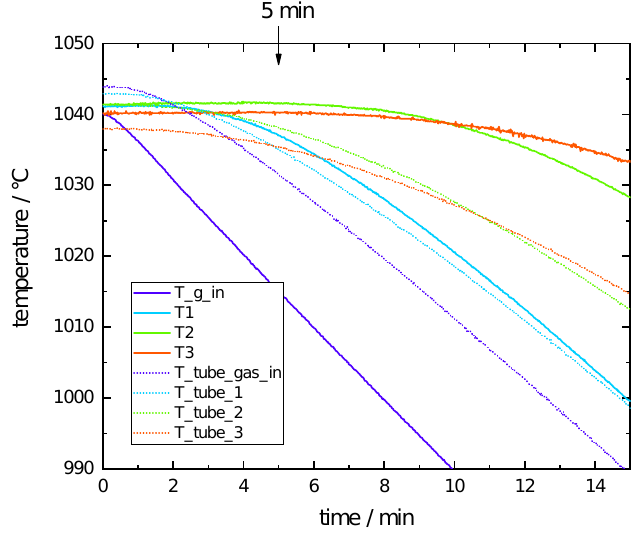
Figure A2. Temperatures of the gas, bulk material, and outer reactor tube wall during the first 15min of the fixed-bed discharging experiment for the validation of the simulation. The position of the tube temperatures corresponds to the same height of the bulk temperature in the radial